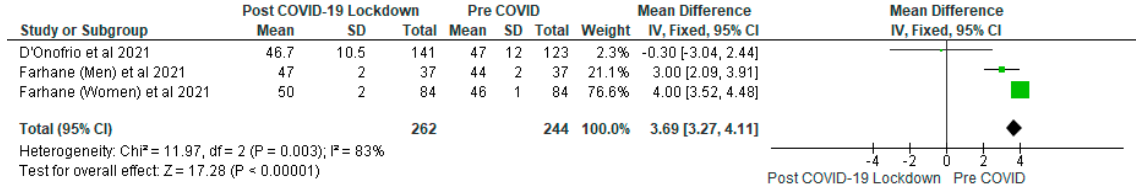
Figure 9. The effect of COVID-19 lockdown on HDL Cholesterol (mg/dL).